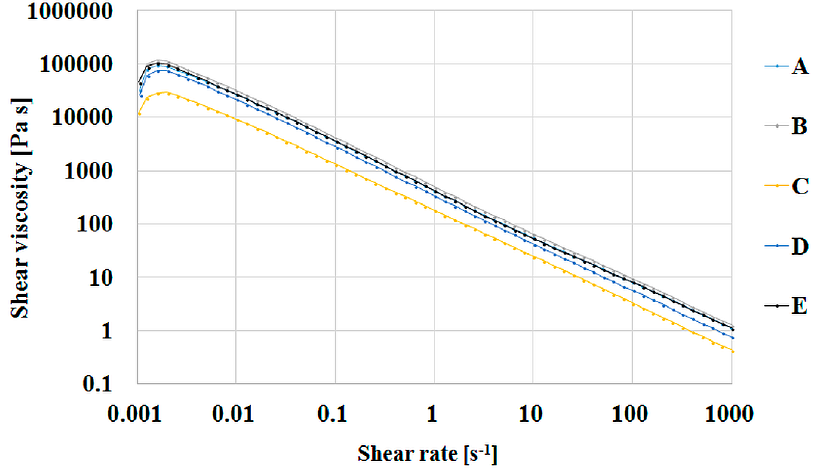
Figure 9. Shear viscosity as function of shear stress for salecan-citric acid hydrogels where A-S5; B-S4; C-S1; D-S2; E-S3. C-S1; D-S2;